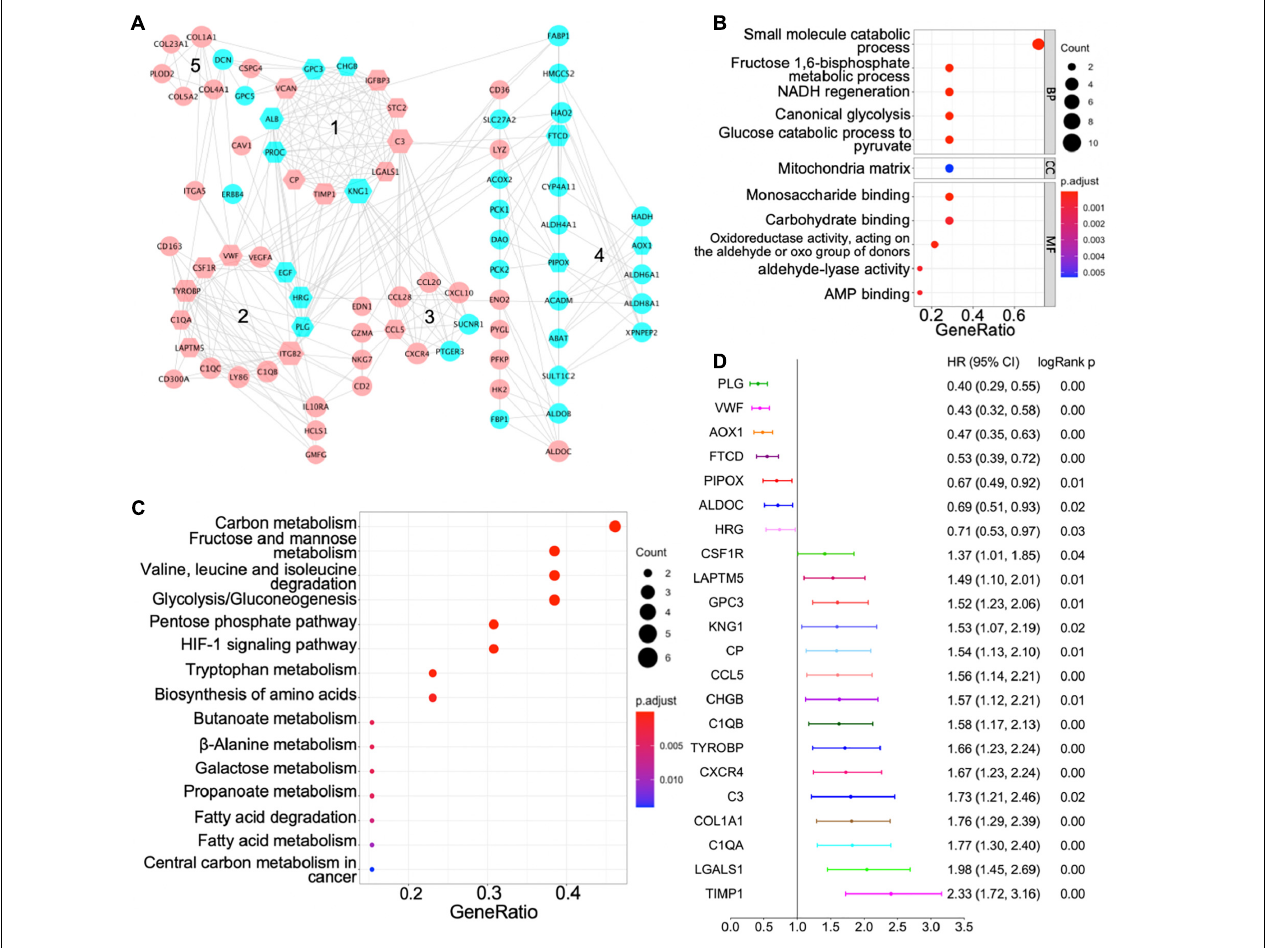
FIGURE 3 | Protein–protein interaction (PPI) network of shared differentially expressed genes and hub genes. (A) PPI network of shared differentially expressed genes showing interactions of different functional modules. Blue and pink indicate downregulation and upregulation, respectively. Major hub genes are marked by hexagons. Numbers label different functional modules. (B) The Gene Ontology (GO) terms of biological process (BP), cellular component (CC), and molecular function (MF) for functional module 4 in the PPI network. (C) The Kyoto Encyclopedia of Genes and Genomes (KEGG) pathway analysis of functional module 4 in the PPI network. (D) Forest plot demonstrating survival analyses of major hub genes identified in the PPI network. HR, hazard ratio; CI, confidence